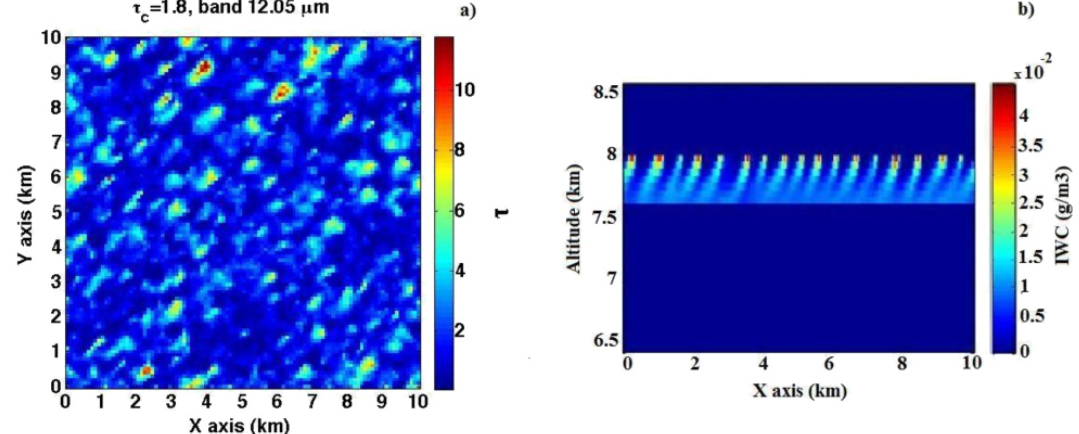
Figure 1. (a) 10km × 10km optical thickness field at 12 . 05µm with a horizontal spatial resolution of 100m; (b) x-z view of the cirrus ice water content (IWC) with a vertical spatial resolution of 58m.